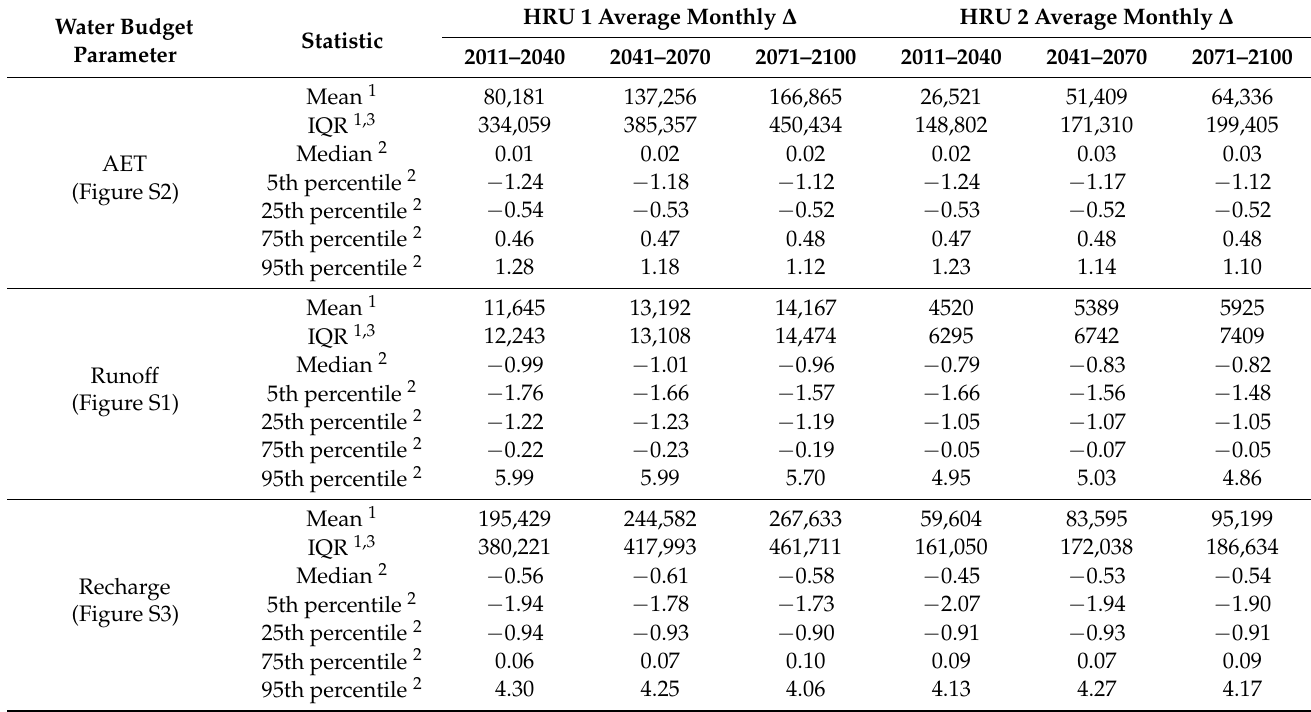
Table 3. CC Scenario Water Budget Component Results for HRU 1 and 2.